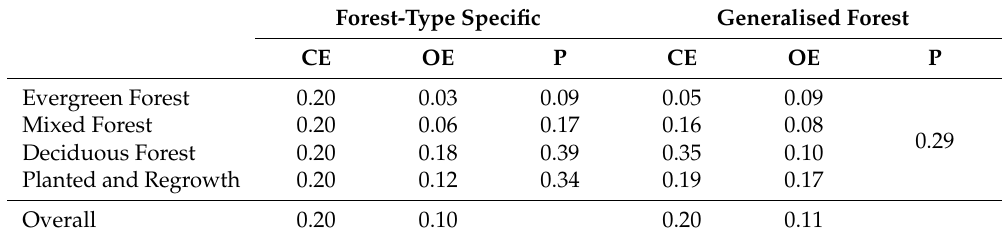
Table D2. Forest clearance commission errors (CE) and omission errors (OE) for different forest types using forest-type specific models and the generalized forest model. The example presented chooses probability thresholds (P) with the goal of attaining a commission error of 0.20 . Data for the table are illustrated in Figures 5 and 6 in the main article. Errors and probabilities are rounded to two decimal